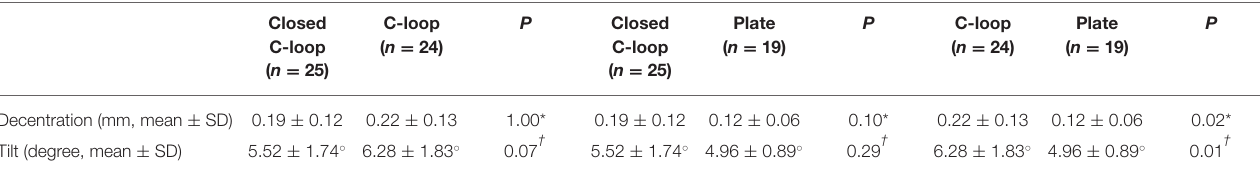
TABLE 3 | Intraocular lens stability with different